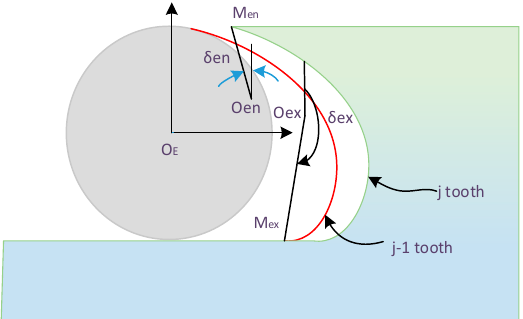
Figure 7. Entry and exit angle in the trochoid trajectory of tool edge.